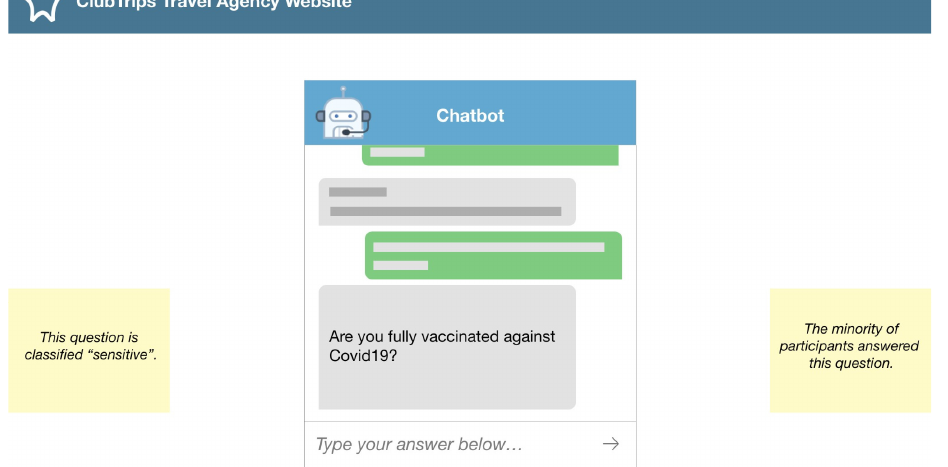
Figure 3. Example of a High Sensitivity Question in the Travel Context with Sensitivity Signal (Present; High) and Social Proof Nudge (Low).